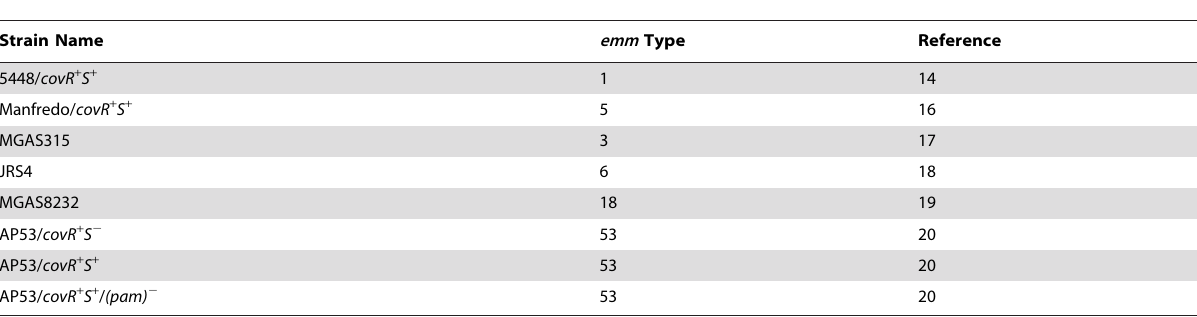
Table 1. Streptococcus pyogenes strains used in this